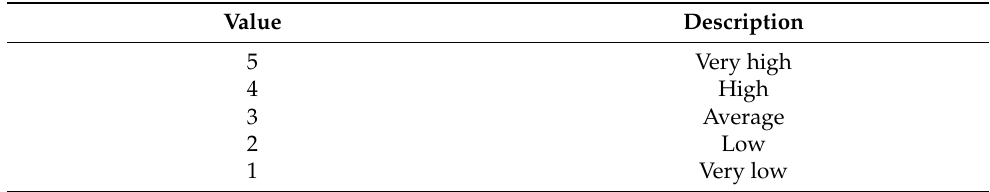
Table 8. Example of the scale used in criteria g4 and g5.